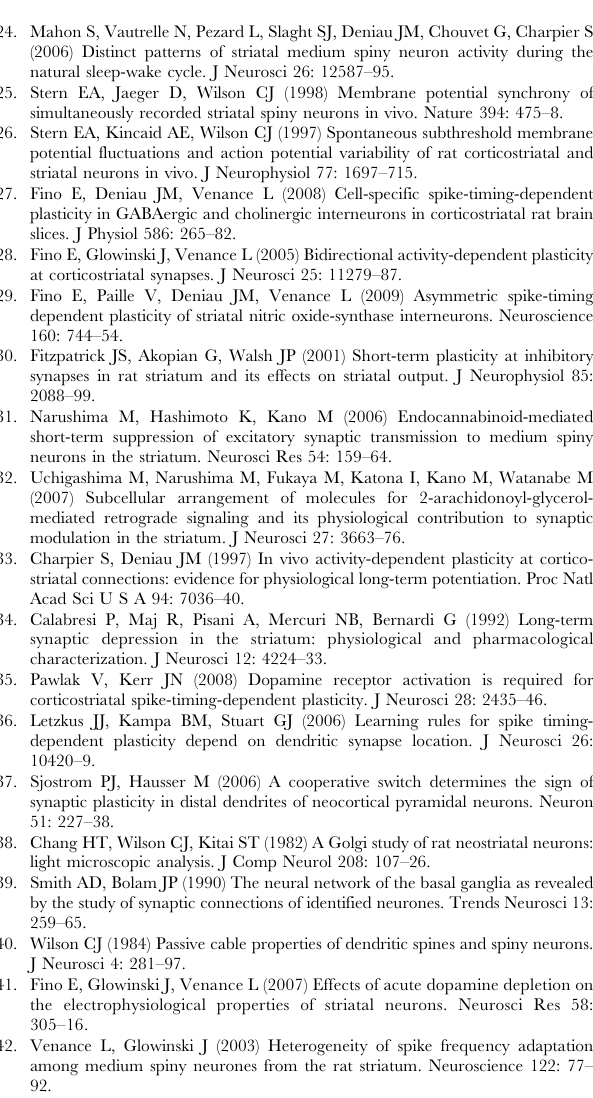
Figure S1 Characterization of SDDP. The magnitudes of long- term synaptic efficacy changes were plotted against EPSC rise time in control (A), EPSC latency in control (B), EPSC amplitude in control (C), RMP (D) and input resistance (E). No significant correlation was found between these parameters and the magnitude of long-term synaptic efficacy changes induced by SDDP protocols (r values are indicated in each